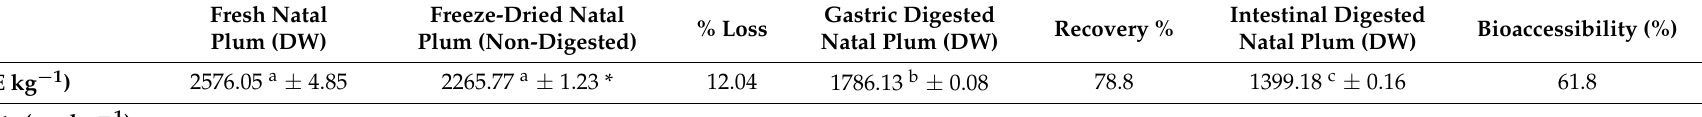
Table 2. Changes in phenolic components in Natal plum fruits during freeze drying and gastrointestinal digestion on a dry weight